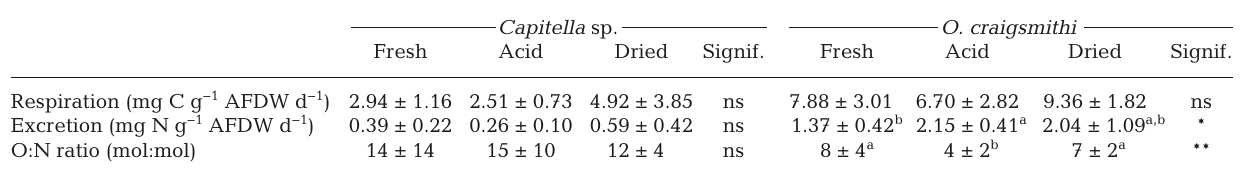
3. C and N required for metabolic processes based on respiration and excretion and subsequent O:N ratios of Capitella sp. and Ophryotrocha craigsmithi fed 3 different diets (fresh, acid-preserved and oven-dried salmon faeces). Values are mean ± SD (n = 8 tanks treatment −1 ). All data of Capitella sp. and excretion data and O:N ratios of O. craigsmithi were log transformed before statistical analyses. a,b Means within a row lacking a common superscript letter differ significantly (p < 0.05). *p < 0.05, **p < 0.01,